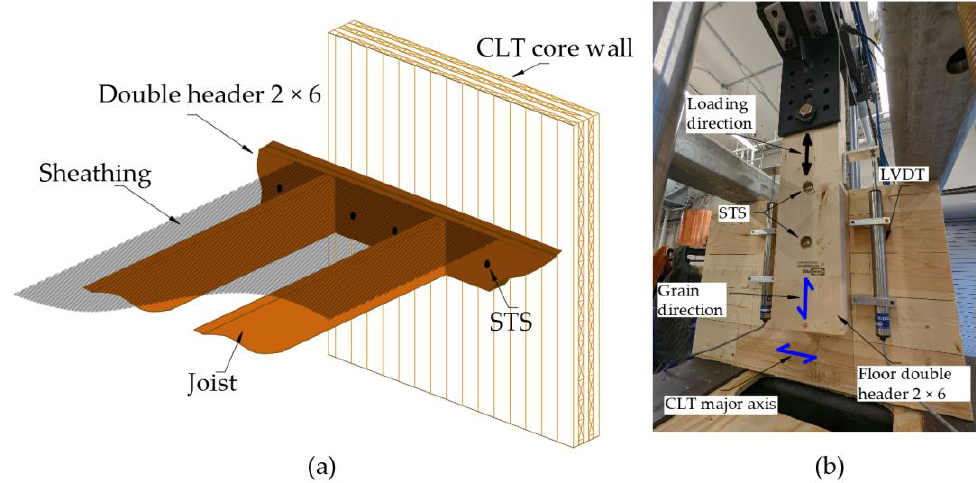
Figure 1. Self-tapping screw connections: ( a ) schematic of STS connections used in CLT and light- frame wood hybrid systems; ( b ) test specimen setup.